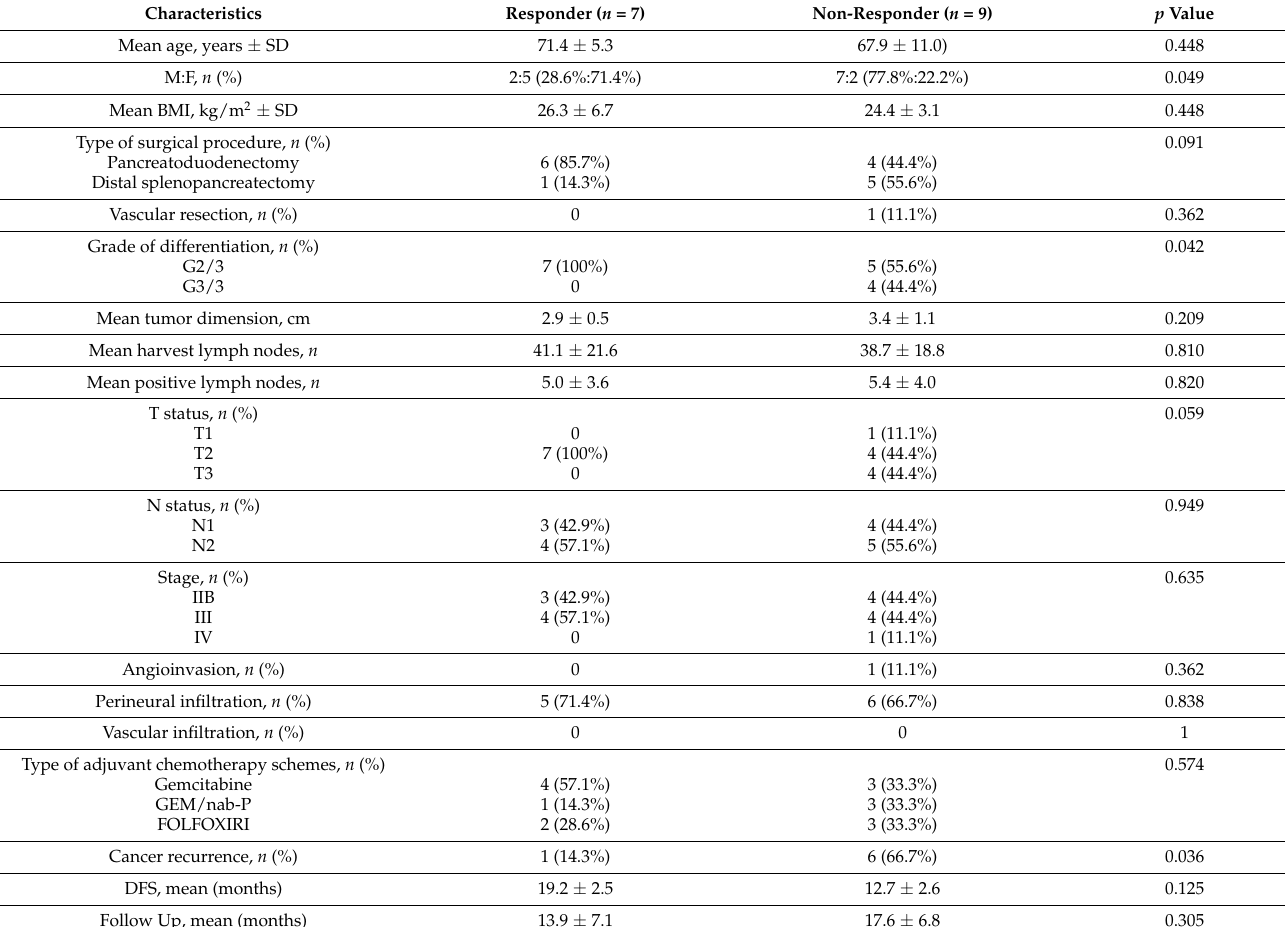
Table 2. Clinical and biological characteristics of PDAC patients eligible for the follow-up ( n = 16).